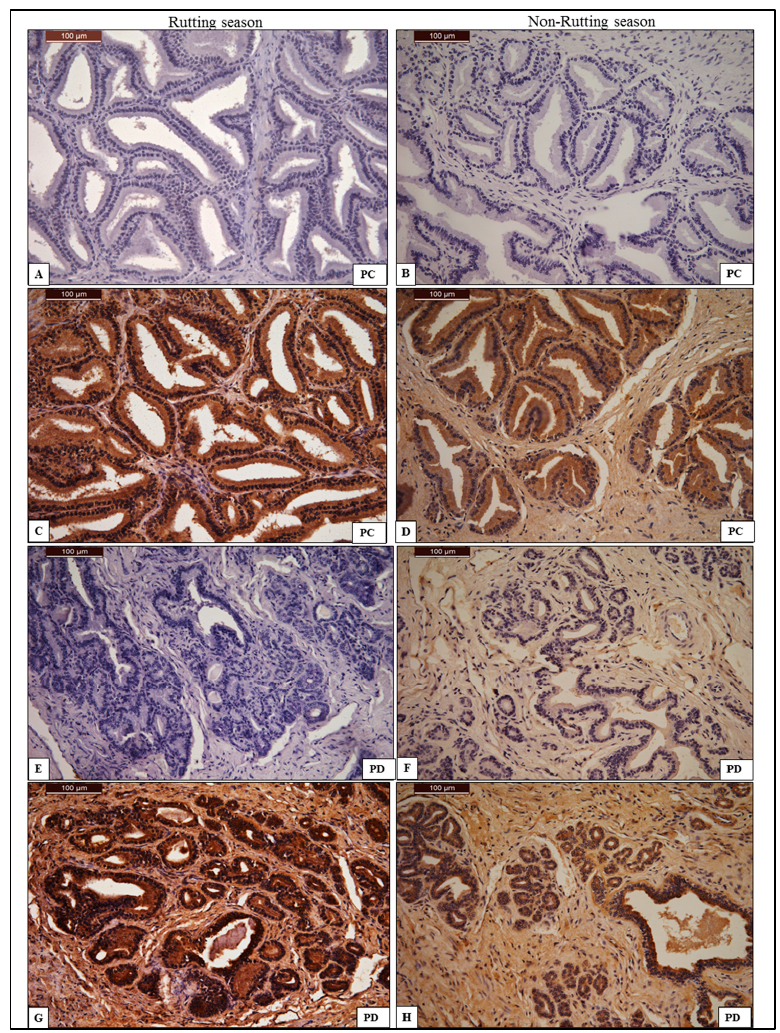
Figure 5. Chromogenic immunohistochemistry of anti-AQP-7 antibody in the compact part (PC) and disseminated part (PD) of the prostate gland. ( A , E ): negative control of anti-AQP-7 antibody in PC